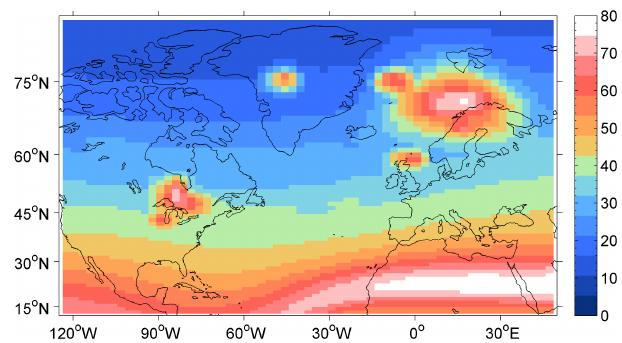
Figure 3. Number of rays with ground stations (black